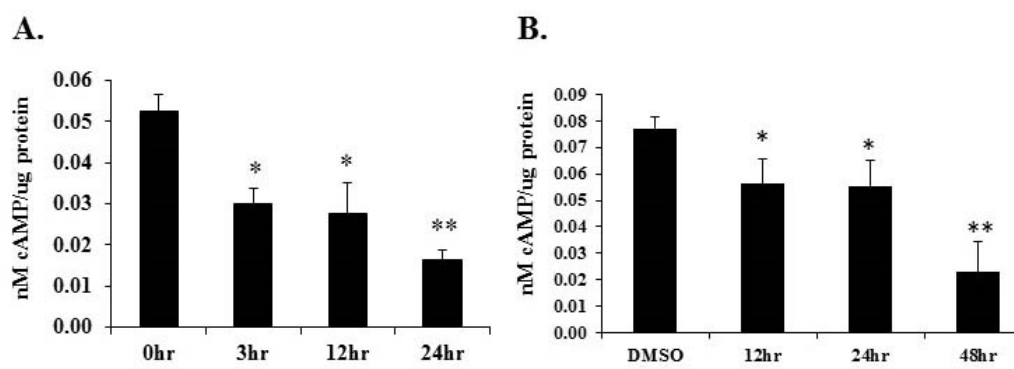
Figure 5. Cyclic AMP (cAMP) protein levels reduced upon Wy-14,643 treatment in H9c2 cardiomyocytes and WT mouse hearts: ( A ) WT mice were injected with 250 mg/kg body weight of Wy-14,643 and hearts were excised at 3-, 12- and 24-h post treatment. cAMP levels in total heart lysates were measured by ELISA and normalized to total protein. ( B ) H9c2 cardiomyocytes were treated with 100 μM Wy-14,643 dissolved in DMSO for 12-, 24-, and 48-h. cAMP levels in total cell extracts were determined by ELISA and normalized to total protein. Samples were compared to controls by t -test, n = 4–6 per group, * p < 0.05, ** p < 0.001.